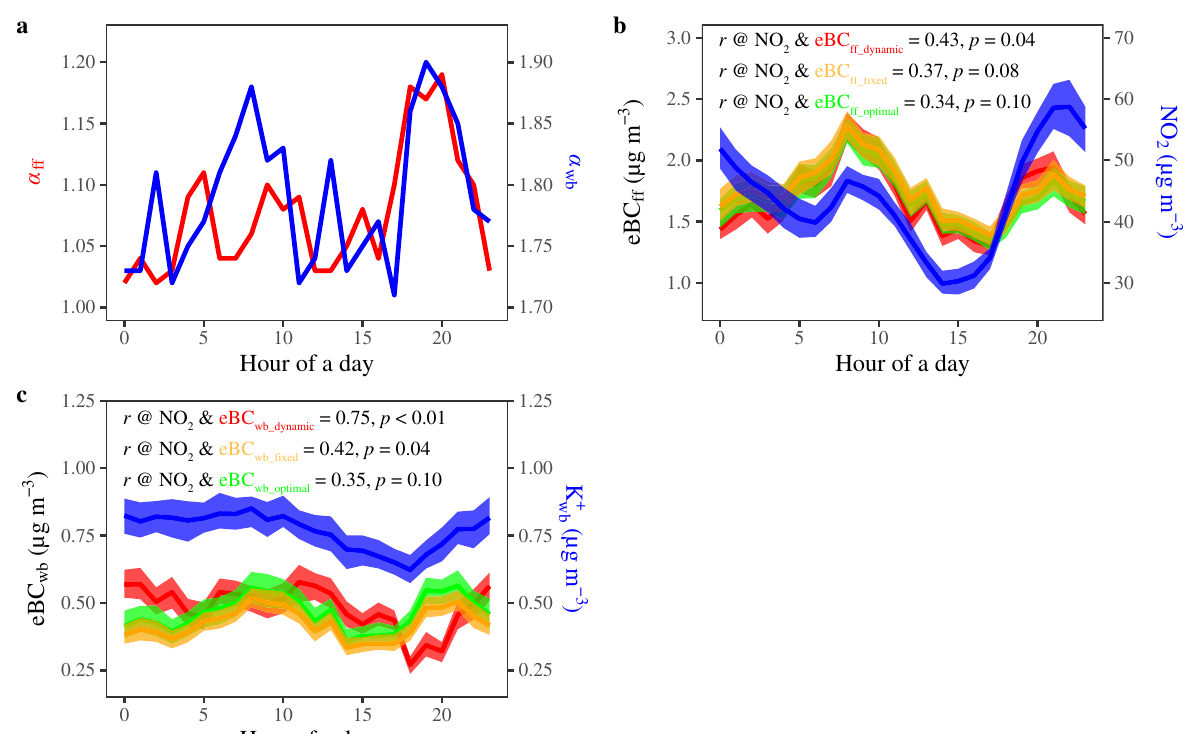
Fig. 4 Diurnal variations of optimal absorption Ångström exponent and black carbon source apportionment results. a Diurnal variations of optimal absorption Ångström exponent for aerosol from fossil fuel ( α ff ) and wood burning ( α wb ). b Diurnal variation of black carbon from fossil fuel (eBC ff ). c Diurnal variation of black carbon from wood burning (eBC wb ). The red, orange, and green lines in panel b and c represent the source apportionment results using the dynamic optimal (values in panel a ), fi xed ( α ff = 1.0, α wb = 2.0), and optimal ( α ff = 1.0, α wb = 1.79) α combinations, respectively. The fi lled areas in panels b and c represent the 95% con fi dence intervals of mean